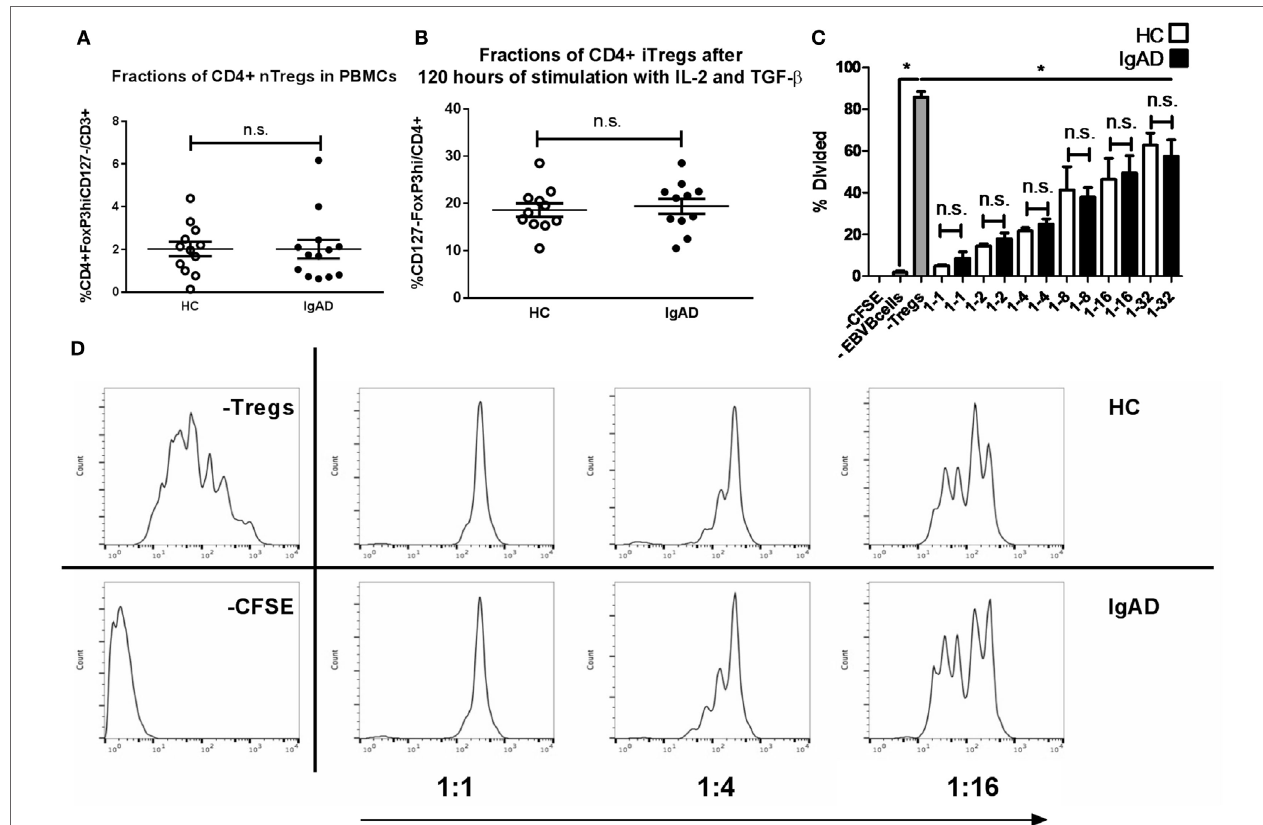
FigUre 5 | The numbers, inducibility, and functions of Tregs are not hampered in selective IgA deficiency (IgAD). The figure shows natural Tregs (nTregs) as measured by flow cytometry on ex vivo PBMCs (a) , induced Tregs (iTregs) on CD4 + CD25 − T cells stimulated for 4 days by anti-CD3 ε , anti-CD28, IL-2, and transforming growth factor beta 1 (B) , and suppressive capacity of the iTregs as measured by a suppression assay with super antigen-pulsated Epstein–Barr transformed B cells (EBV-B) cells and allogenic PBMCs (c) , comparing IgAD and controls. (a) The proportion of cells expressing a CD4 nTreg phenotype characterized by CD4 + CD127 − CD25 hi forkhead boxP3(FoxP3 hi ) expression was not found to differ in IgAD from healthy controls (HC). (B) Neither did in vitro induced CD4 + iTregs after 4 days of stimulation. (c) The suppressive capacity of the iTregs from IgAD is intact and comparable to HC at different ratios when comparing proliferation of fluorescent 5,6-carboxyfluorescein succinimidyl ester (CFSE) stained CD8 T cells in allogeneic co-cultured PBMCs stimulated by super antigen- pulsated EBV-B cells. (D) A representative experiment showing a HC and an IgAD individual in a suppressive assay, − CFSE is a negative control with no staining, − Tregs shows a positive control of proliferation without Tregs. All data are from five-independent experiments, no duplicates. Significance was calculated in relation to the control group. * p < 0.05, ** p < 0.01, *** p < 0,001 (as determined by one-way ANOVA).